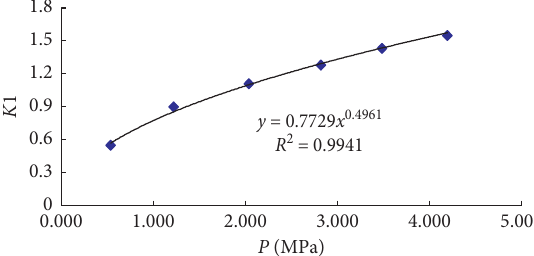
Figure 5: K – P relationship model in the 2# connection roadway 1 in the 121901 working face.